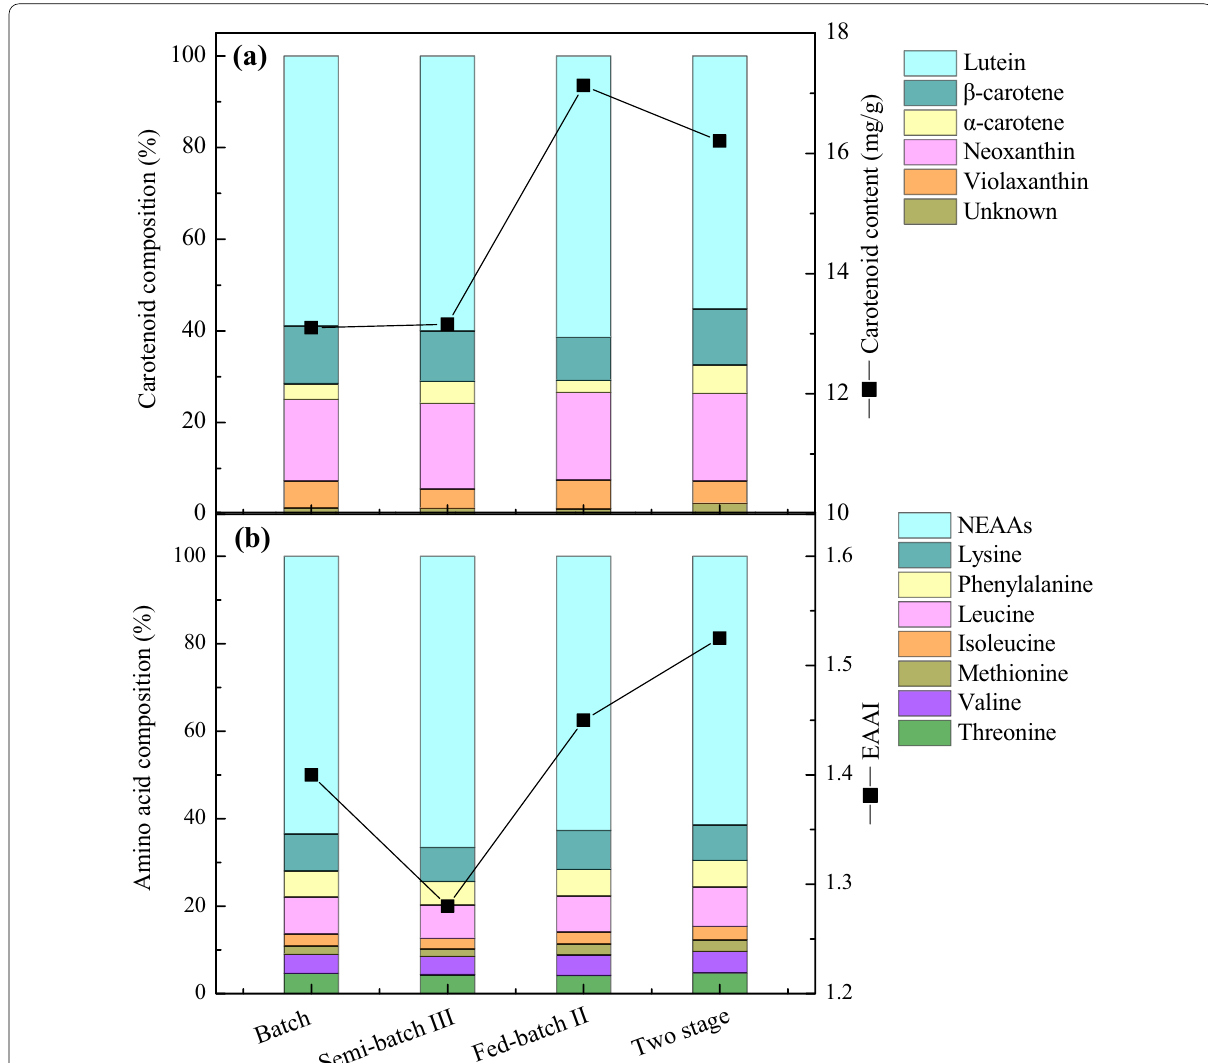
Fig. 5 Carotenoid and amino acid composition in C. sorokiniana FZU60 under different cultivation strategies. a Carotenoid composition; b amino acid